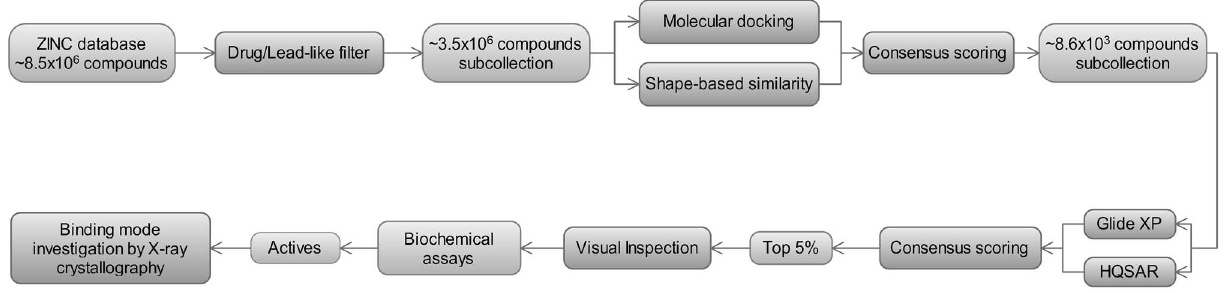
Figure 2. A scheme of the multi-step virtual screening protocol used for the identification of cruzain inhibitors.